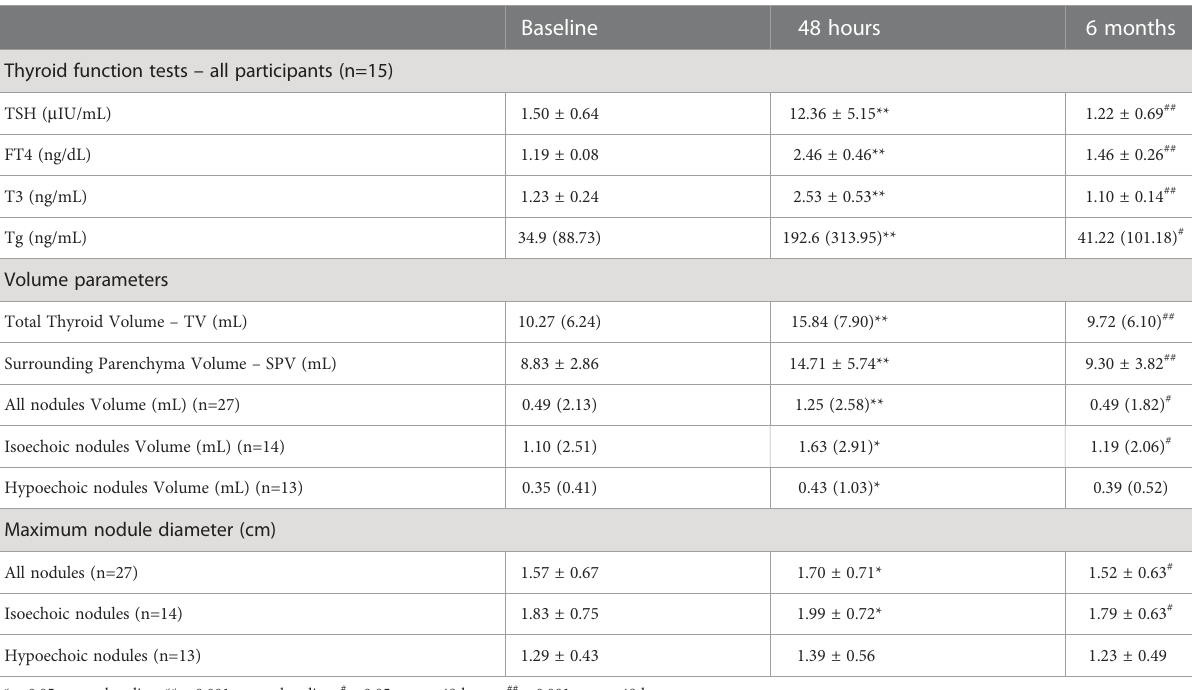
TABLE 1 Thyroid function tests, total thyroid, surrounding parenchyma and nodules ’ volumes, and maximum nodule diameter measured before and 48 hours and 6 months after the administration of human recombinant TSH. Baseline 48 hours 6